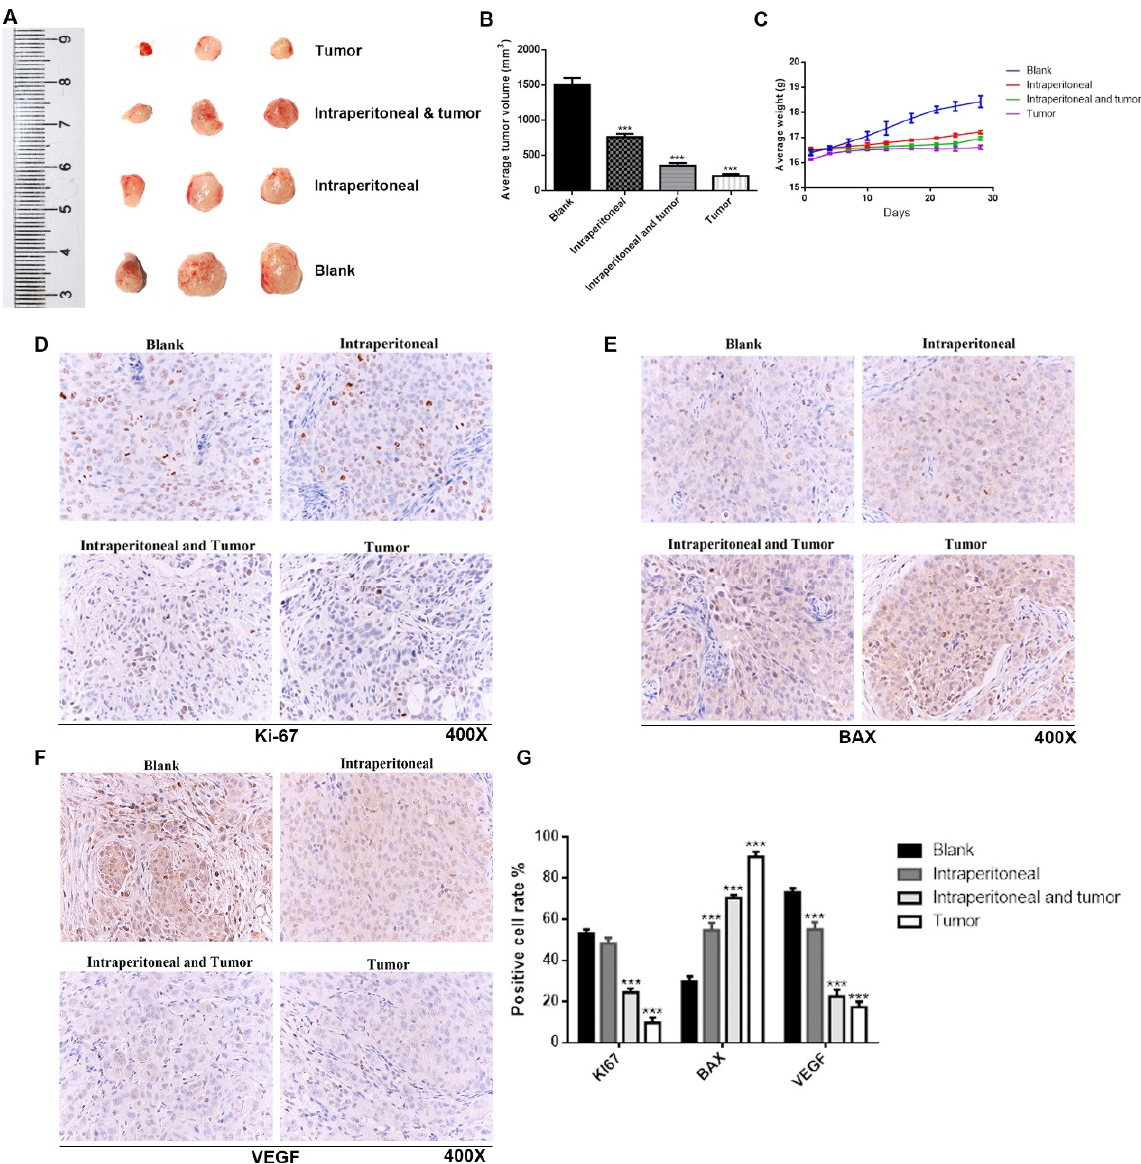
Figure 6. Verification of anticancer effect of TSO in nude mice transplantation experiment. ( A ) BALB/c nude mice were taken for xenotransplantation, and the size was measured by the beside ruler. ( B ) The volume of anatomized subcutaneous xenograft tumors was measured and analyzed by Student’s t -test. ( C ) The body weight of nude mice in each group also showed significant difference due to tumor size. ( D – G ) Representative Ki-67, BAX and VEGF immunohistochemical staining micrographs of xenograft tumors were performed. Ki-67 and VEGF were significantly reduced after administration. BAX increased significantly after administration. Data are mean ± SD, n = 3; *** p < 0.001 vs. Blank.